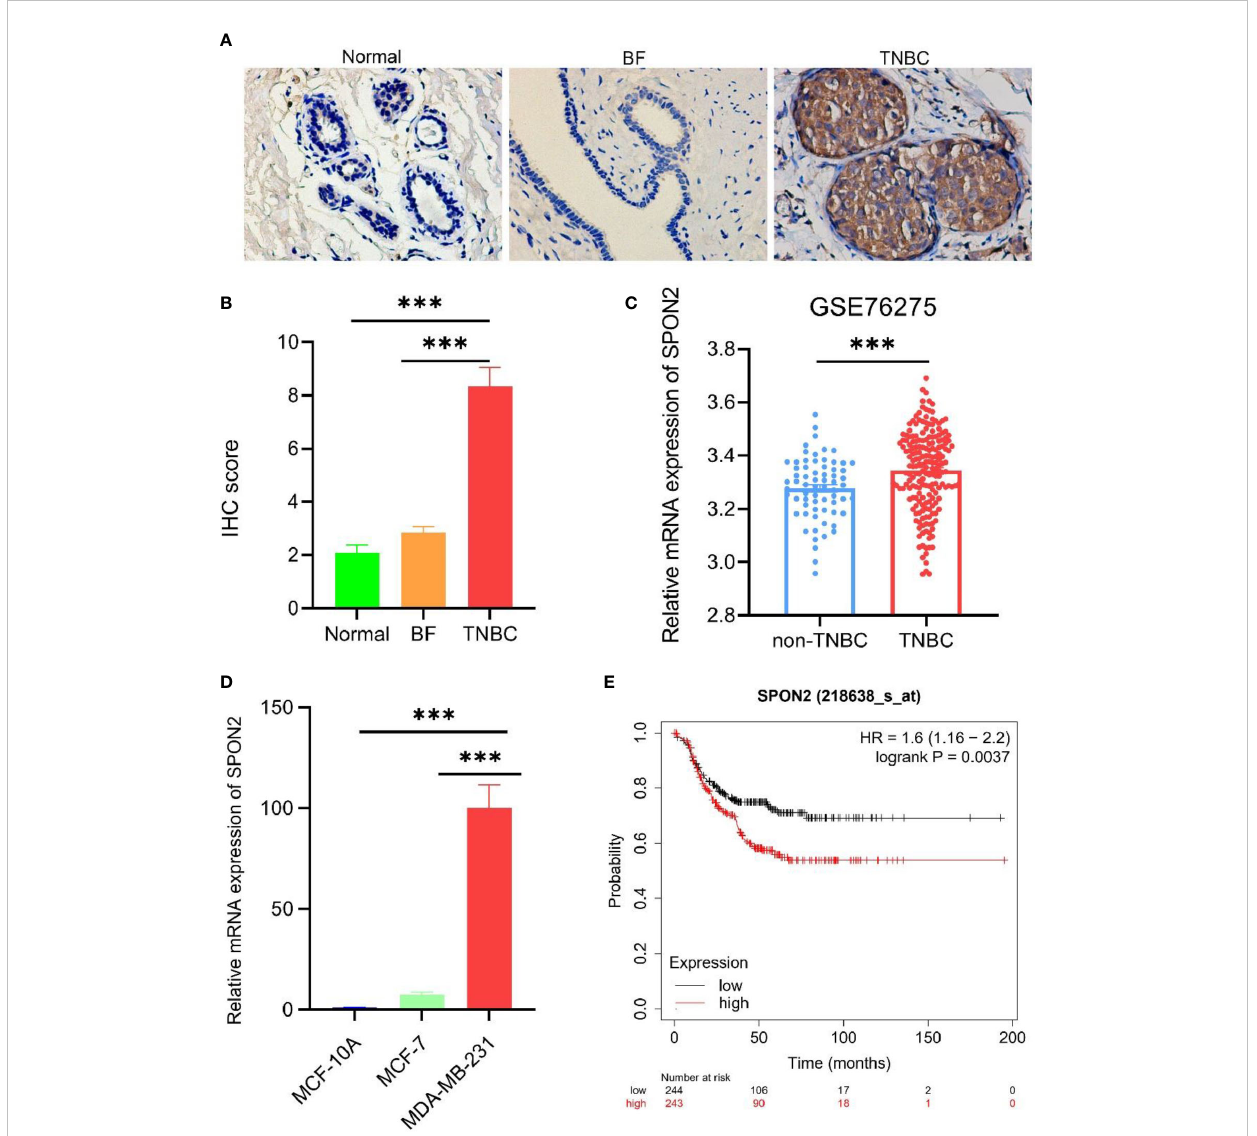
FIGURE 1 SPON2 is highly expressed in TNBC and leads to poor prognosis. (A, B) Immunohistochemical detection of SPON2 protein expression in TNBC, breast fi broadenoma (BF), and normal tissue adjacent to TNBC cancer showed that SPON2 protein was highly expressed in TNBC. Magni fi cation times: ×200. (C) SPON2 mRNA expression levels were higher in TNBC than in non-TNBC breast cancer (non-TNBC) in the GSE76275 dataset. (D) The qPCR assay showed that SPON2 mRNA was highly expressed in MDA-MB-231. (E) High SPON2 expression in TNBC had worse recurrence- free survival. *** P <